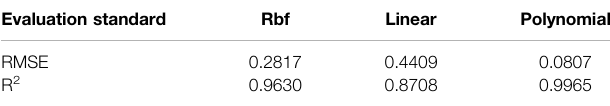
TABLE 6 | Comparison of kernel function precision.